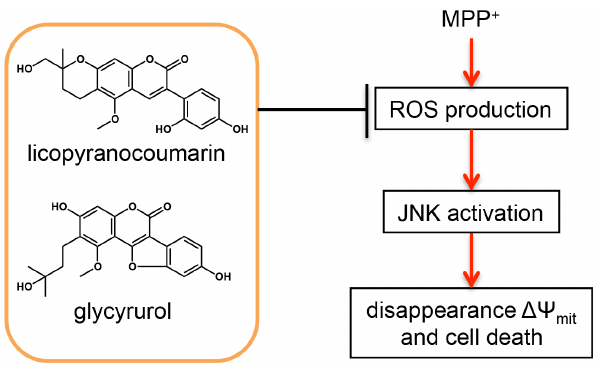
Figure 9. Suggested model for neuroprotection of licopyrano- coumarin and glycyrurol against MPP + -induced toxicity in PC12D cells. Both licopyranocoumarin and glycyrurol exert neuro- protective effects against MPP + -induced toxicity via suppression of ROS generation and of JNK activation.